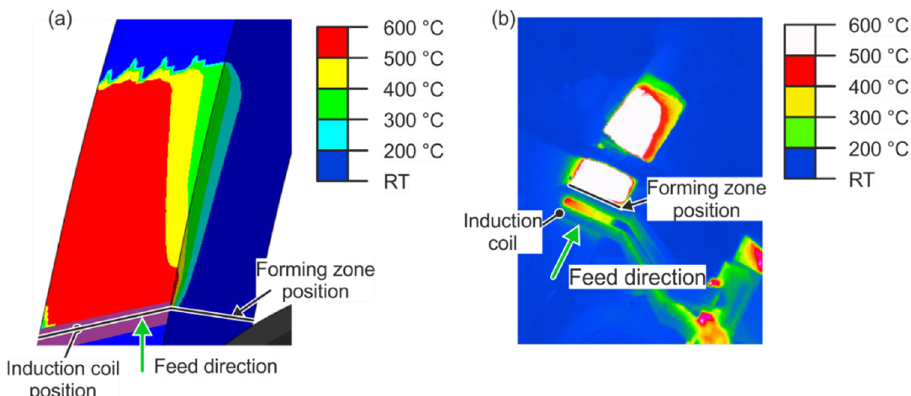
Figure A1. Temperature distribution in the kinematic push-bending phase for 600 °C heating temperature and 8 mm/s feed velocity. ( a ) simulated temperature distribution, ( b ) thermographic measurement.